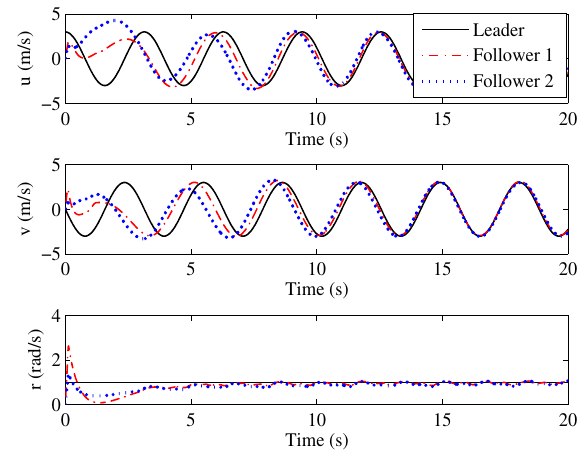
Figure 17. Velocities of the leader and